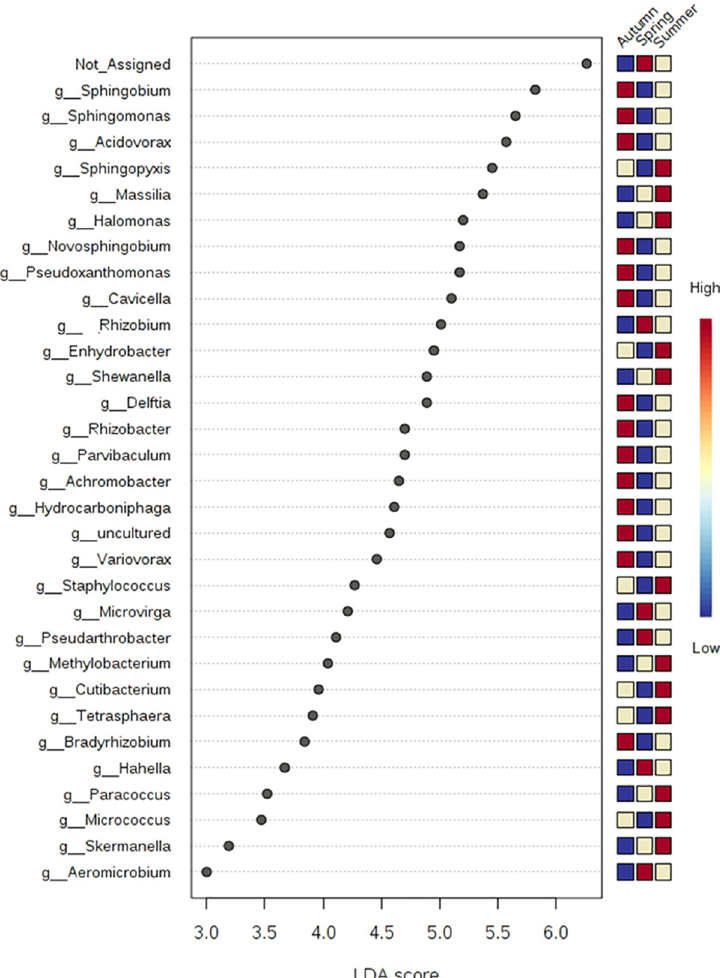
Fig 6. LDA analysis based on non-parametric factorial Kruskal-Wallis (KW) sum-rank test of bacterial genus among three seasons (p & q � 0.05). The heat map on the right side of the figure explains the abundance of the genera in three different seasons depicted by the three colours. Blue (low abundance), beige (median abundance) and red (high abundance).